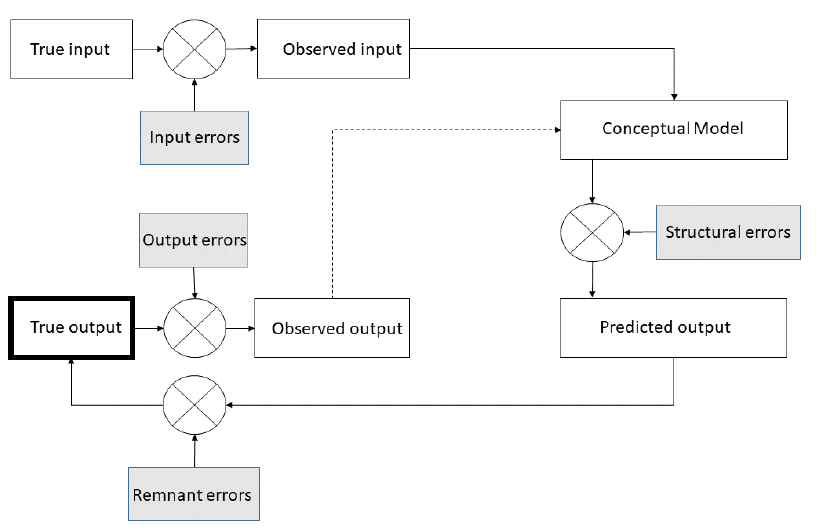
Figure 1. Pipeline in between input, output, a conceptual model and its prediction. Dashed arrow corresponds to the need of output for the training of the model.